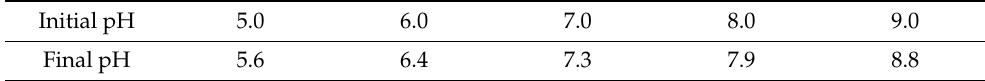
Table 1. The pH value changes of the aluminum–air fuel cell before and after operation for 60 min.